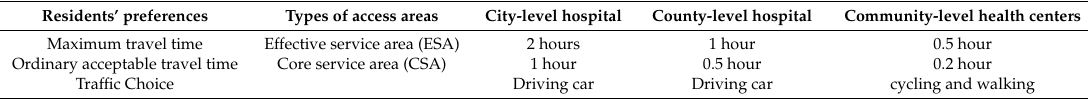
Table 2. Residents’ spatial behavioral preferences of visiting multilevel